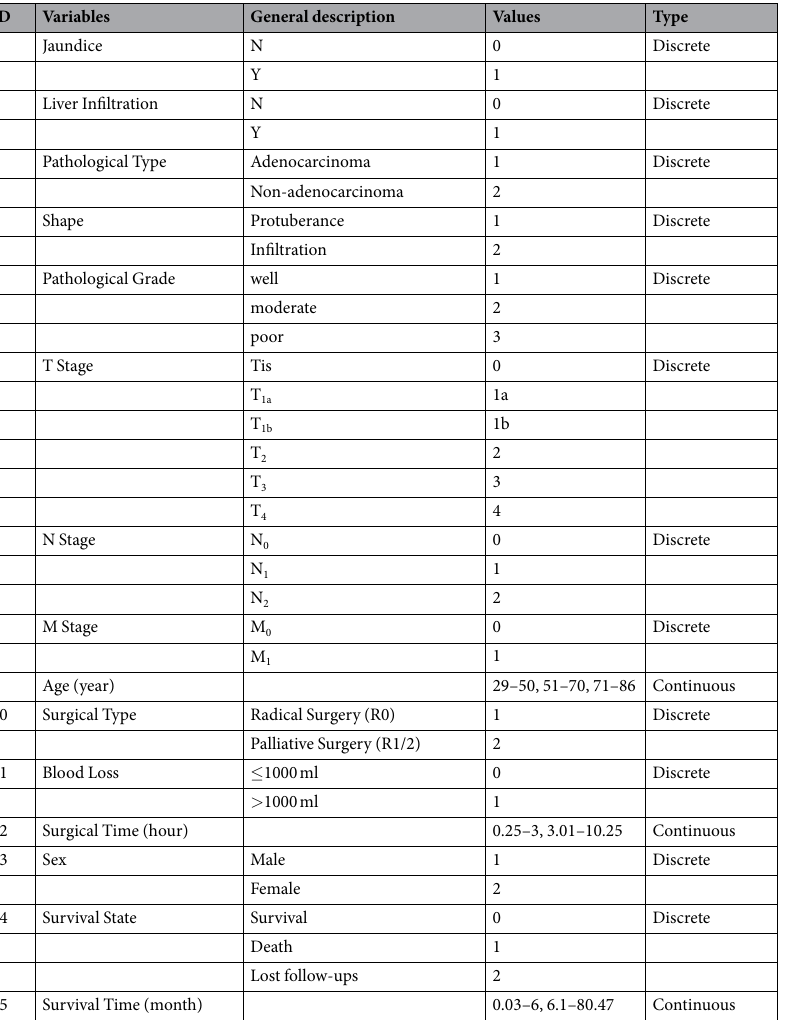
Table 5. Standard description of data. Jaundice was defined by the serum bilirubin level exceeding 32.4 umol/L (2 mg/dL). Clinical end-points and measurements included imaging examination such as abdominal ultrasound, Computed Tomography (CT) and Magnetic Resonance (MR) scan, and assaying serological tumor markers, which included the determination of carbohydrate antigen 125 (CA-125), carbohydrate antigen 19-9 (CA19-9) and carcinoembryonic antigen